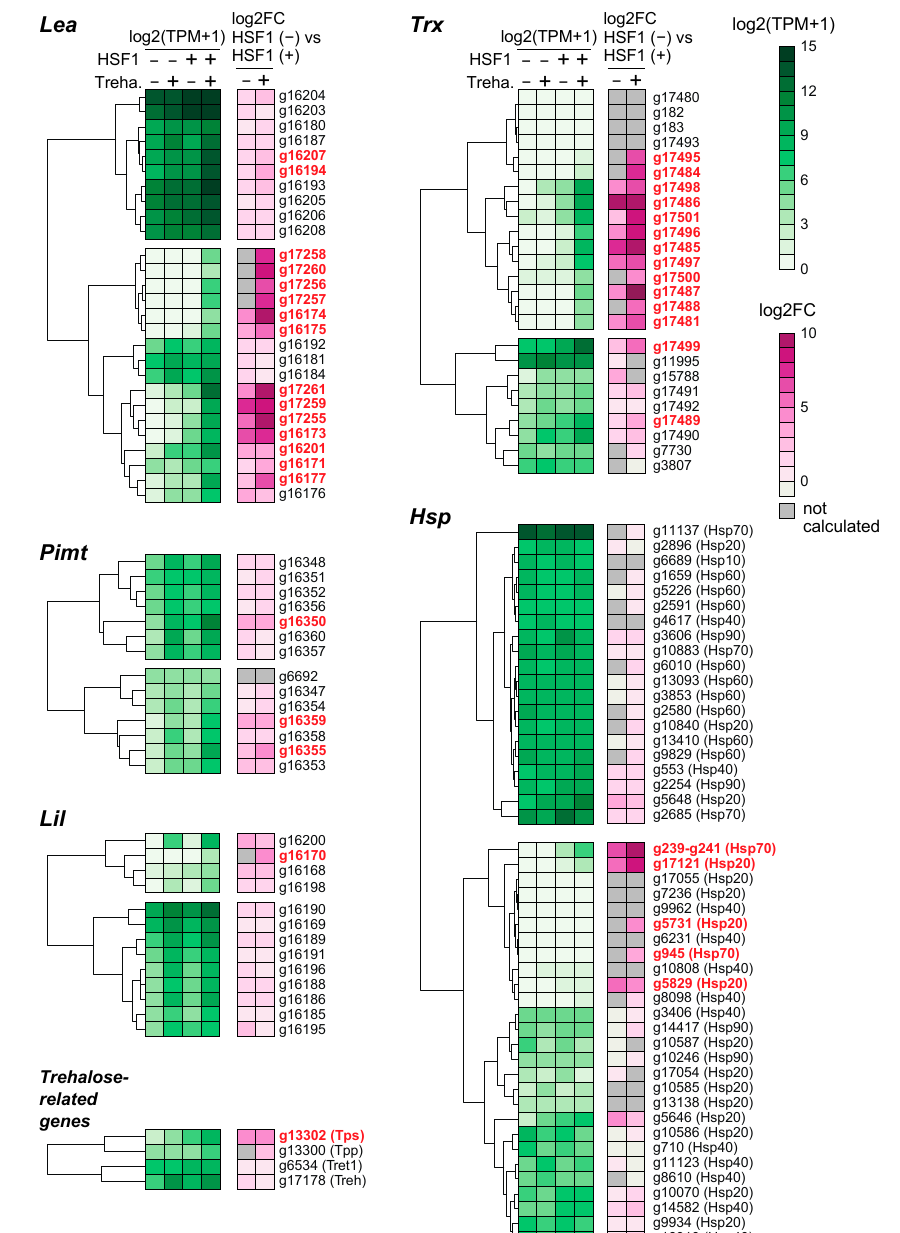
Figure 5. Heatmaps of mRNA-seq log2 (TPM: tags per kilobase per million + 1) and log2FC values for the anhydrobiosis-related genes Lea , Trx , Lil , Pimt , Hsp and trehalose metabolism-related genes. The log2 (TPM +1) values were calculated by applying log2 on TPM + 1 values. Fold-changes were calculated by comparing TPM values of Hsf1 − / − ; Hsf1 -HaloTag/BlaR and Hsf1 − / − ; HaloTag/BlaR cell lines before (T0) or after trehalose treatment (T48) by using edgeR. All log2 (TPM+1) and log2FC values are shown in Data S10. Red gene names in bold highlight changes in gene expression where log2FC ≥ 3 (TPM comparison, HSF ( − ) vs. HSF (+) in T48). HSF1 ( − ), Hsf1 − / − ; HaloTag/BlaR; HSF1 (+), Hsf1 − / − ; Hsf1 -HaloTag/BlaR; Treha. − , before trehalose treatment (T0); Treha. +, after trehalose treatment (T48); not calculated; the log2FC values were not calculated when the both TPM values were